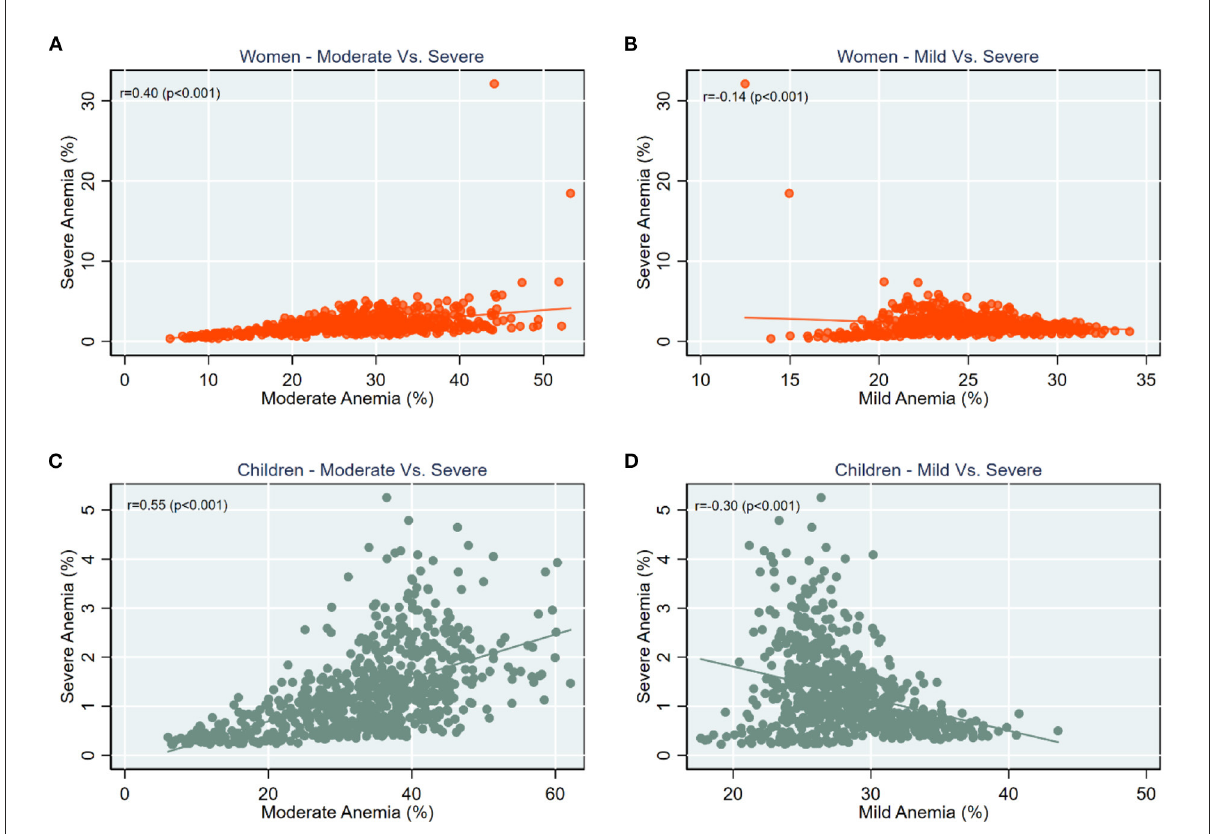
FIGURE1 Scatter plots for correlation between prevalence of (A) Women—moderate vs. severe anemia; (B) Women—mild vs. severe anemia; (C) Children—moderate vs. severe anemia; (D) Children—mild vs. severe anemia, India, NFHS